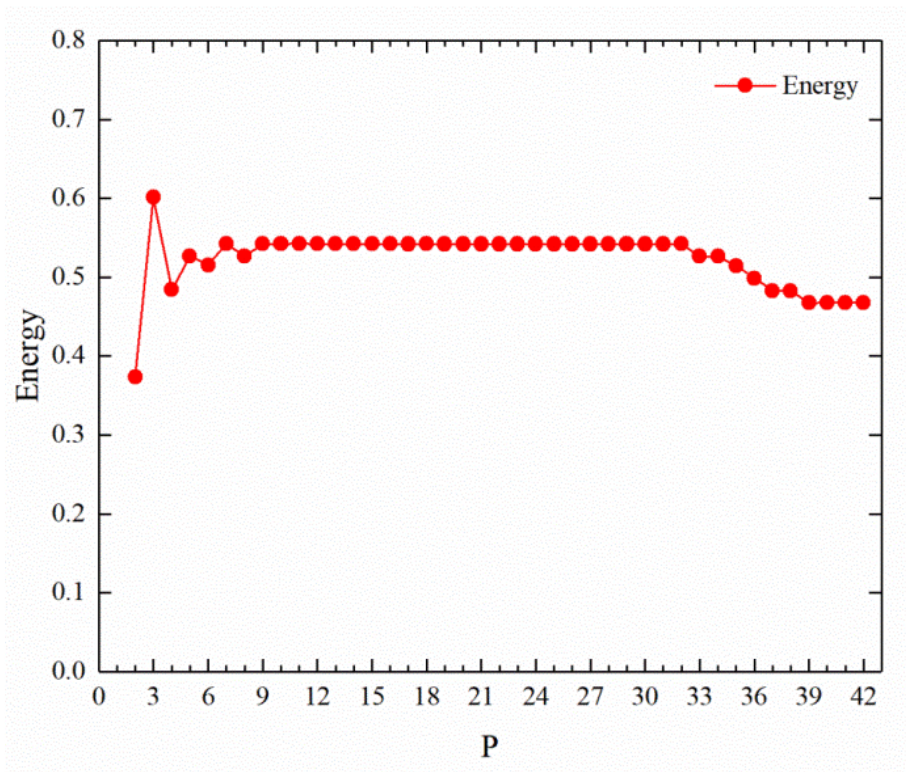
Figure 5. The gray level co-occurrence matrix was calculated to obtain the average value of the energy with different values of p .